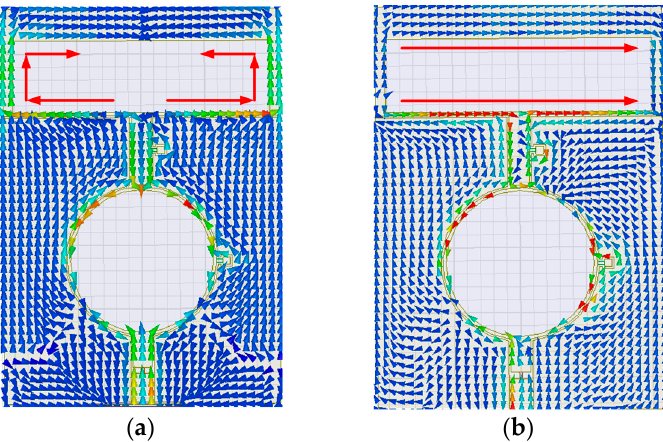
Figure 5. Simulated surface current distribution: ( a ) vertical mode and ( b ) horizontal mode.